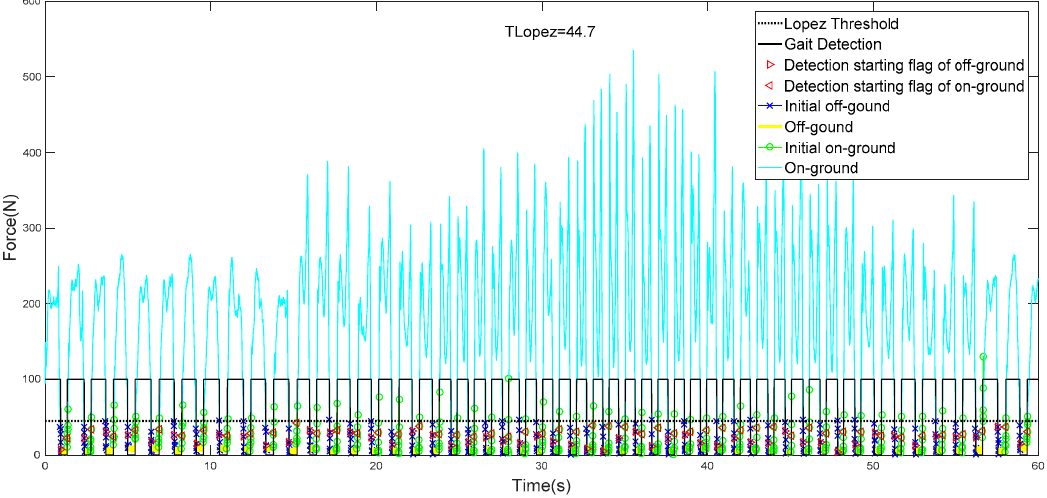
Figure 13. The best result of gait phase detection.